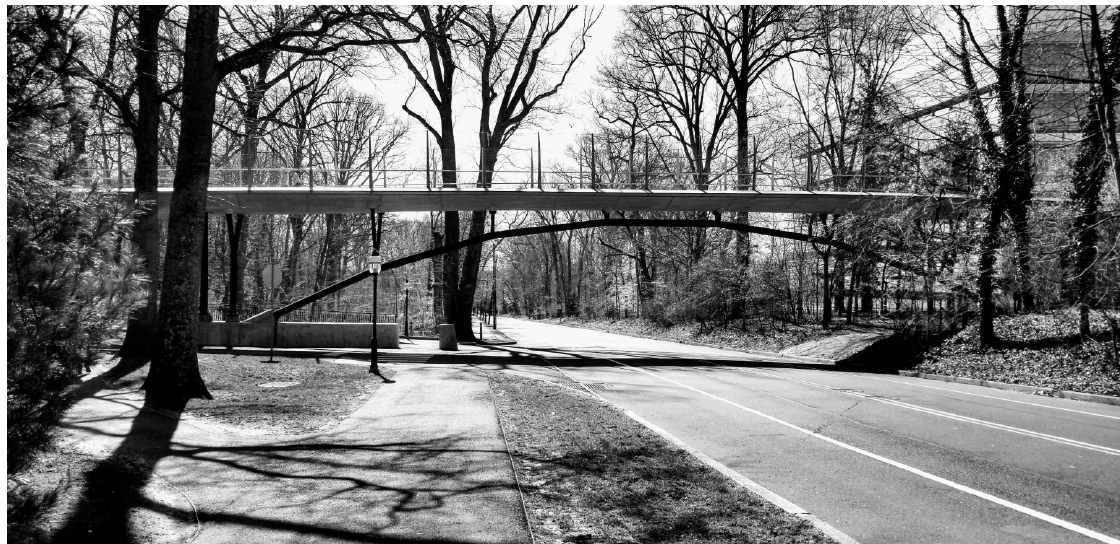
Figure 2. Front view of the Streicker bridge at Princeton University.